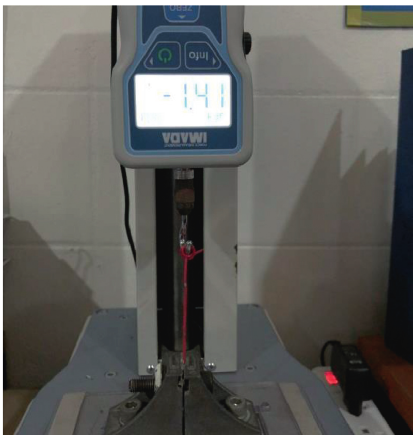
Figure 2: A pull testing setup to measure the pull force required to separate a crimped terminal from a